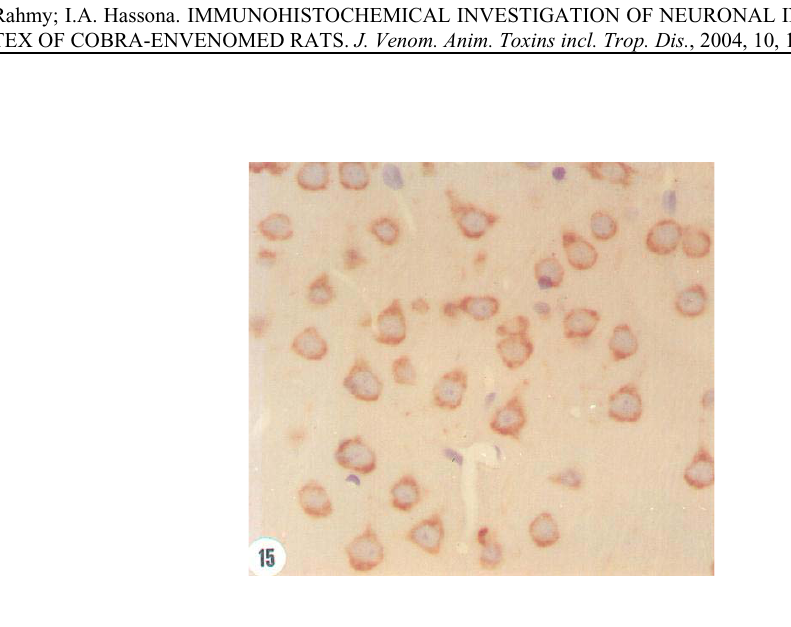
Figure 15. Bcl-2 immunoexpression in the cytoplasm of control neurons. (X400)